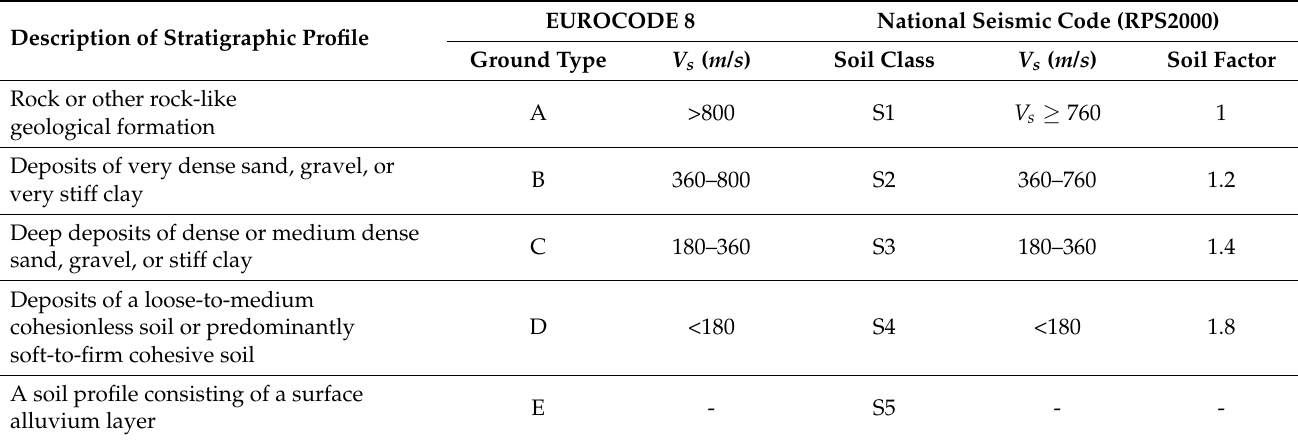
Table 3. Ground types, according to Eurocode 8 [53] and the national seismic standard (RPS2000) [17].